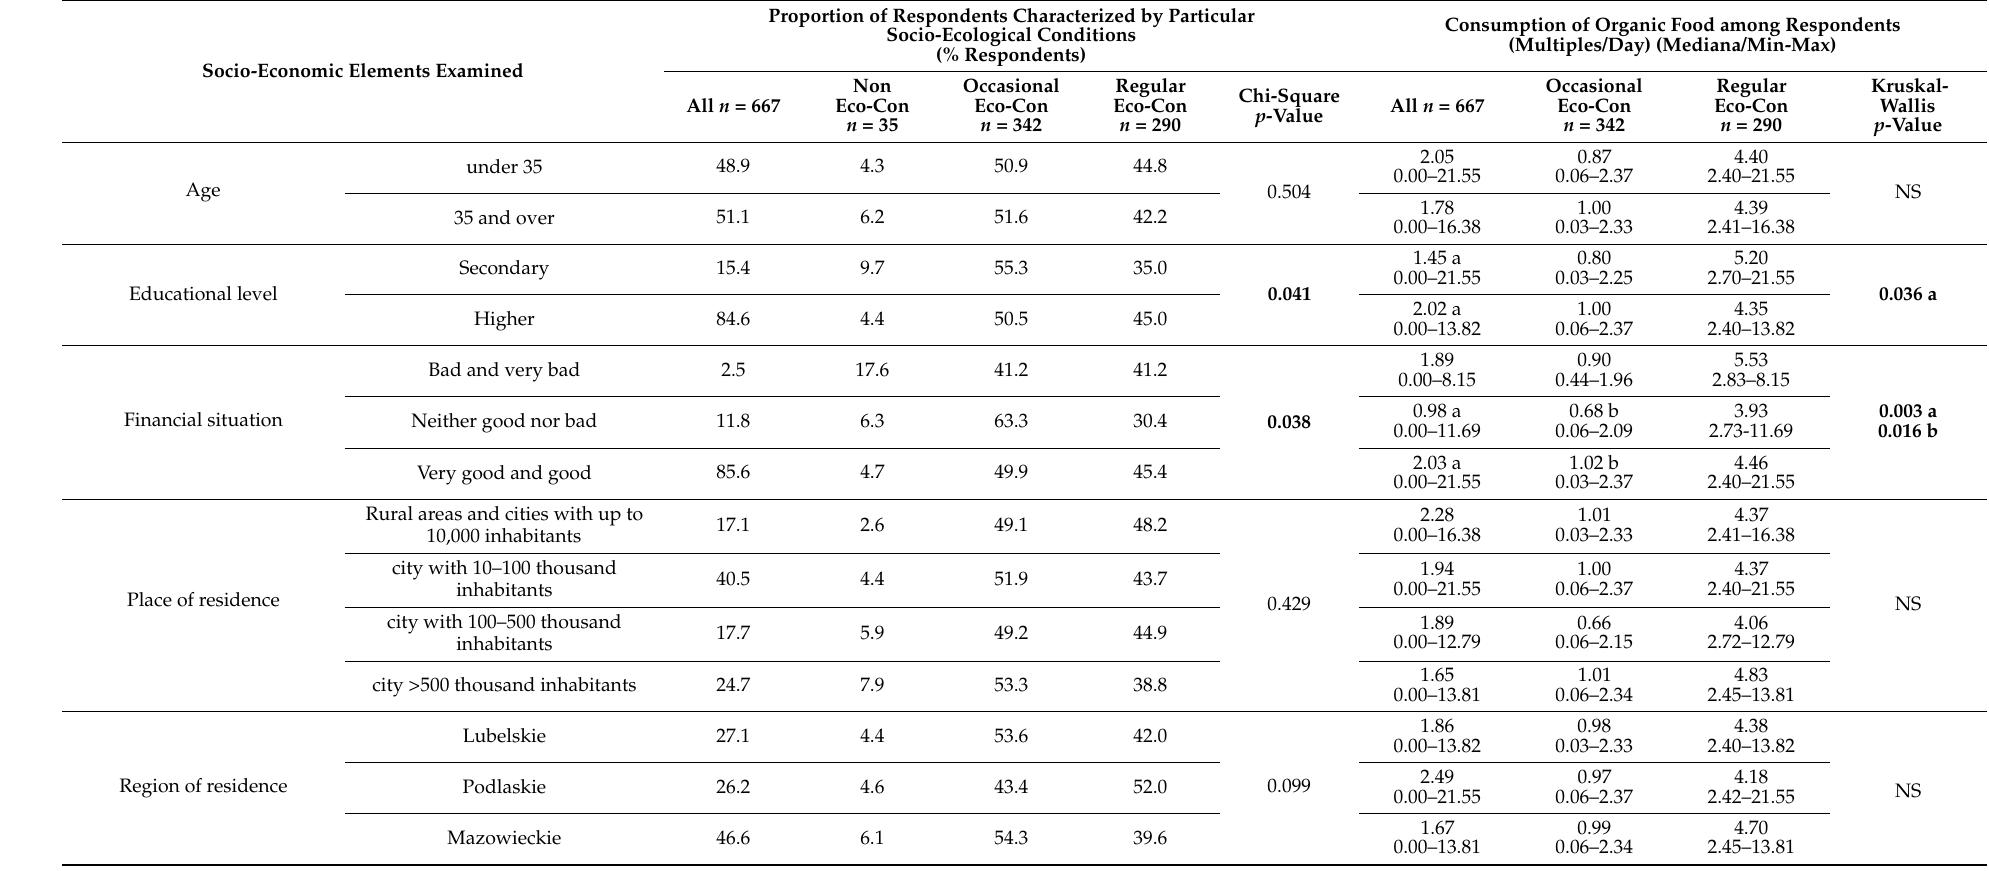
Table 6. Relationship between selected socio-economic factors and level of organic food